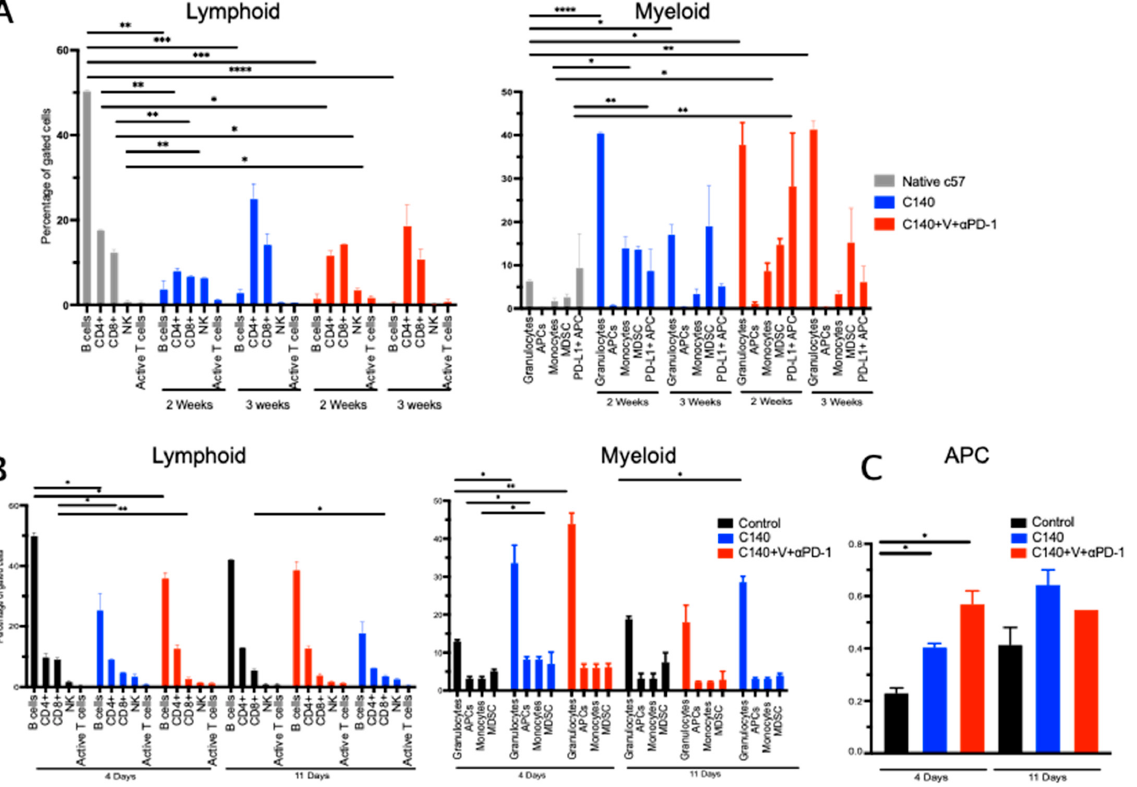
Figure 5. TT reshapes the immune cell landscape in the peripheral blood (PB). ( A ) Flow cytometry analysis in Ly27085-Luc bearing mice treated with C140 and TT at two different time points (two and three weeks after tumor injection). In the graph, major lymphoid (on the left panel) and myeloid cell subpopulations (on the right panel) are shown. Lymphoid comprises B cells (CD19 + ), CD3 + CD4 + and CD3 + CD8 + T cells, NK cells (CD335 + ), and activated CD8 + T cells (CD3 + CD8 + CD69 + CD25 + ). Myeloid cells include granulocytes (CD11b + Gr1 + ), APCs (CD11b − Gr1 − D11c + ), monocytes (CD11b + Gr1 − CD11c + ), myeloid-derived suppressor cells (MDSC) (CD11b + Gr1 + ), and PD-L1 + APC (PD-L1 + CD11b − Gr1 − D11c + ). The Shapiro-Wilk Test was applied to define normal distribution. A 2- tails Student’s t test’ was applied. Statistic is referred to each condition compared to untreated and not injected C57/BL6 mice (in grey in the graph). (* p < 0.05, ** p < 0.01, *** p < 0.001, **** p < 0.0001). ( B ) Flow cytometry analysis in Ly27085-Luc re-challenged mice at two different time points (4 and 11 days after tumor re-challenge). In the graph major lymphoid (on the left panel) and myeloid cell subpopulations (on the right panel) are shown. Lymphoid comprises B cells (CD19 + ), CD3 + CD4 + and CD3 + CD8 + T cells, NK cells (CD335 + ), and activated CD8 + T cells (CD3 + CD8 + CD69 + CD25 + ). Myeloid cells